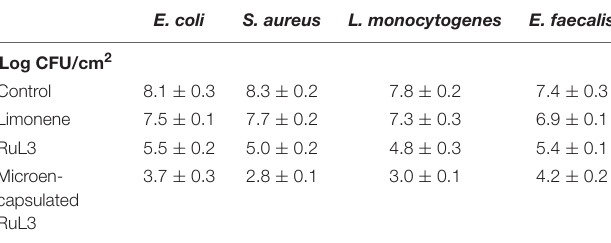
TABLE 2 | Escherichia coli , Staphylococcus aureus , Listeria monocytogenes , and Enterococcus faecalis biofilm log counts after treatment for 10 min with limonene, free and microencapsulated RuL3 at their respective